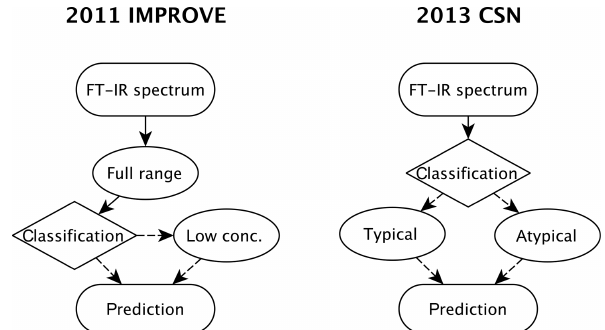
Figure 11. Multilevel modeling strategies used for TOR EC in the IMPROVE and CSN network. In the left figure, “full range” de- notes the calibration model using the full range of TOR EC con- centrations, while the “low conc.” denotes the model using only the lowest third. In the right figure, “atypical” samples were taken from a particular site (ELLA) while the “typical” samples comprised the